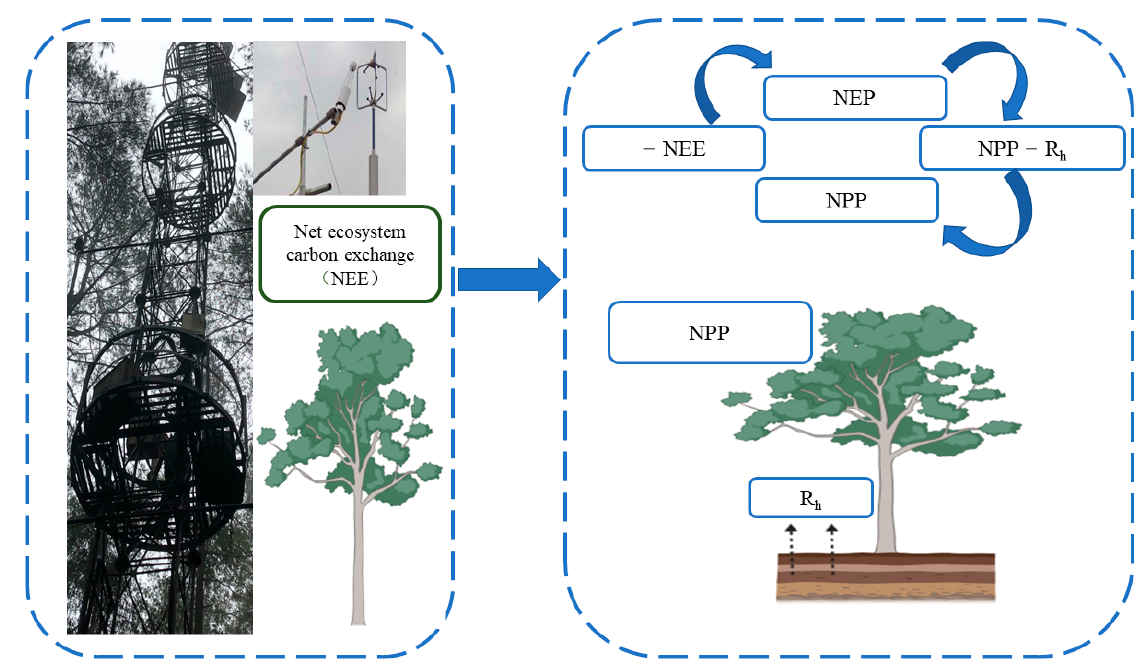
Figure 3. The Eddy Covariance Technique is converted to an NPP schematic diagram after meas- uring NEE. Net primary ecosystem productivity (NEP) can be obtained by directly measuring the NEE value in the vorticity correlation system, and NEP is the difference between NPP and hetero- trophic respiration (R h ). Therefore, the NPP value can be obtained by measuring NEE and hetero- trophic respiration (R h ).